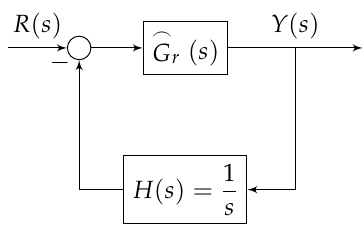
Figure 2: Closed-loop system of high-order continuous interval plant (HOCIP).